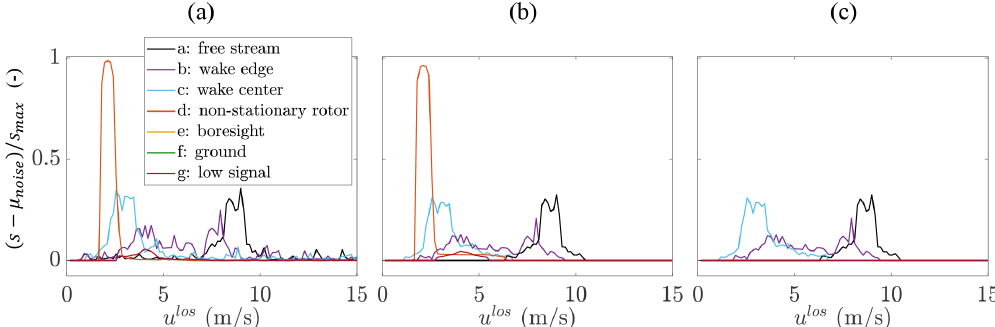
Figure 5. Traces of noise-subtracted and rescaled power spectral density, (s − µ noise )/s max , versus u los where s max = 2 16 − 1. These cases demonstrate the progression of the primary advanced filtering steps: (a) removal of hard targets; (b) bilateral filtering, thresholding, and isolation of RoI; and (c) combined outlier detection method and low signal quality filter.